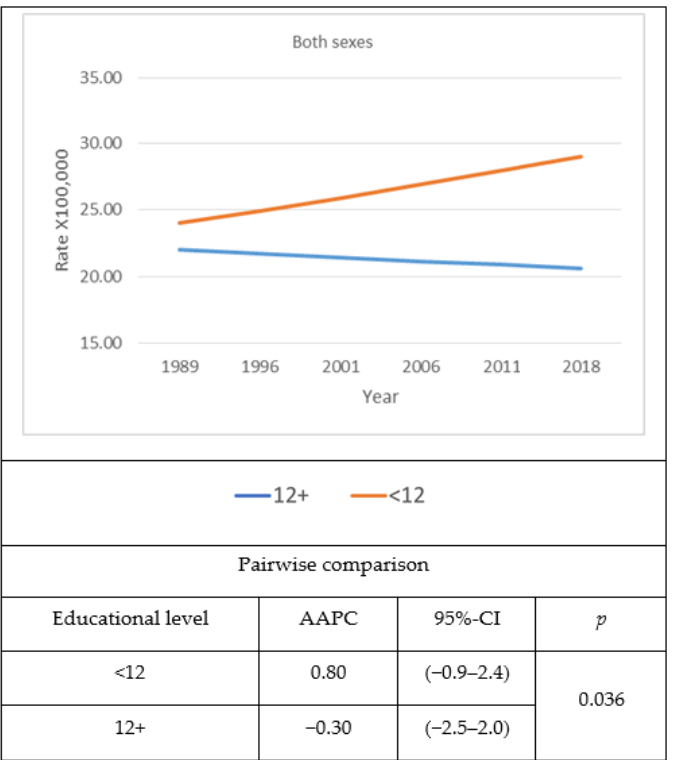
Figure 1. Time trend of age- and sex-adjusted diabetes mortality and average annual percent change (AAPC) among Hispanics in the USA by education level and year from 1989 to 2018. The 2000 USA Census Population was used as standard.